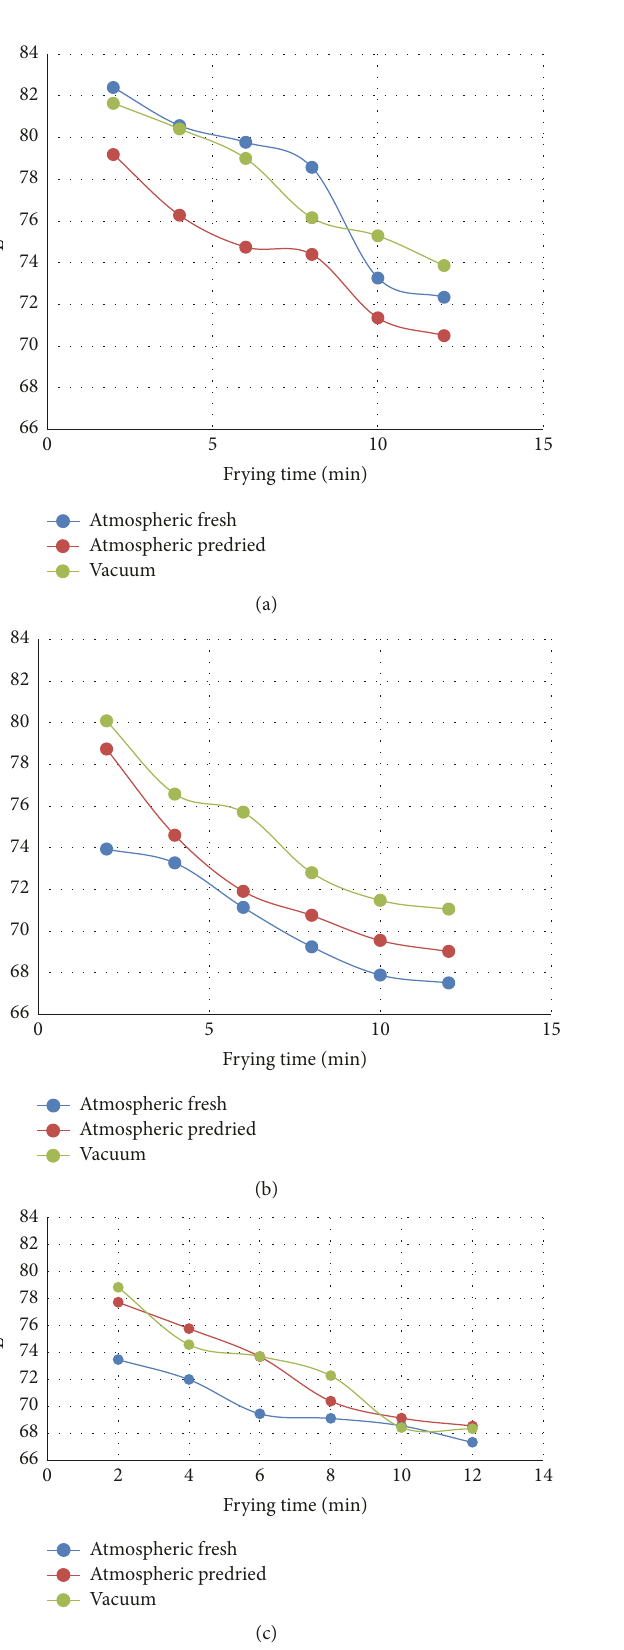
Figure 3: Effect of frying conditions on redness of yellow fleshed cassava chips (YFCC) at different equivalent thermal driving forces (ETDF) of (a) 60 ∘ C, (b) 70 ∘ C, and (c) 80 ∘